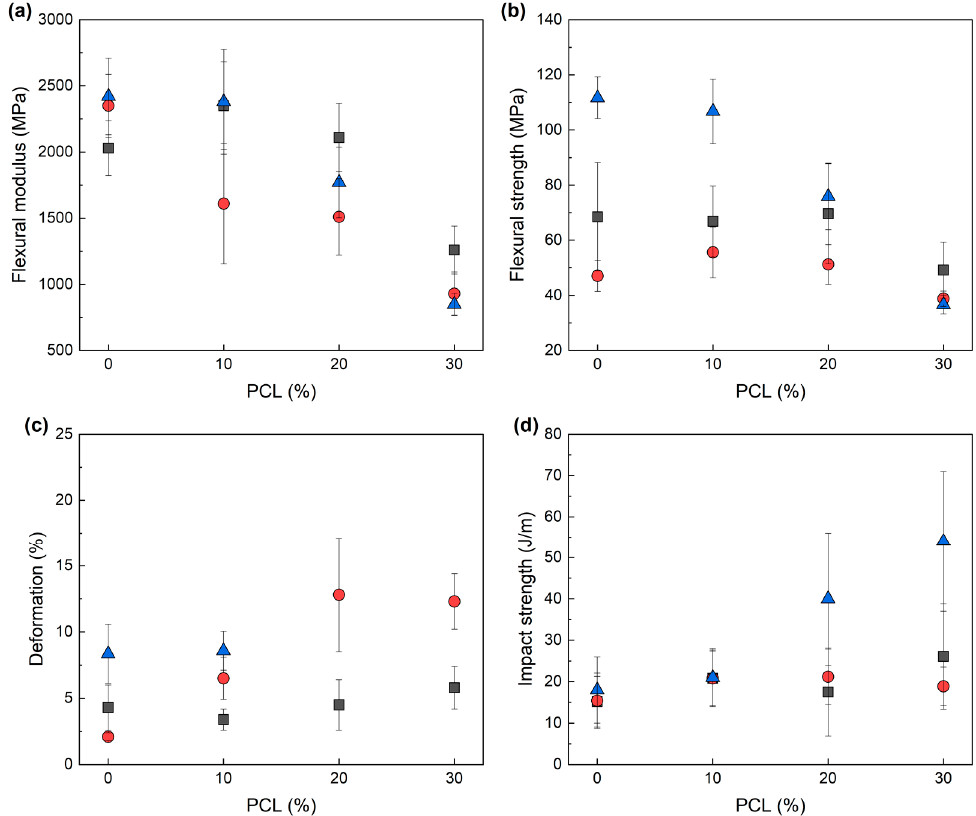
Figure 5. Flexural modulus ( a ), flexural strength ( b ), deformation at break ( c ), and impact strength ( d ) of IL-P-TMPP- ( ■ ), IL-P-DCA- ( ● ), and IL-I-DCA- ( ▲ ) cured epoxy/PCL blends as a function of the PCL content. Deformation at break values of the IL-I-DCA-cured blends containing 20% and 30% of PCL are not shown, as the samples did not break. Table 5. Mechanical properties of the IL-cured epoxy/PCL blends.